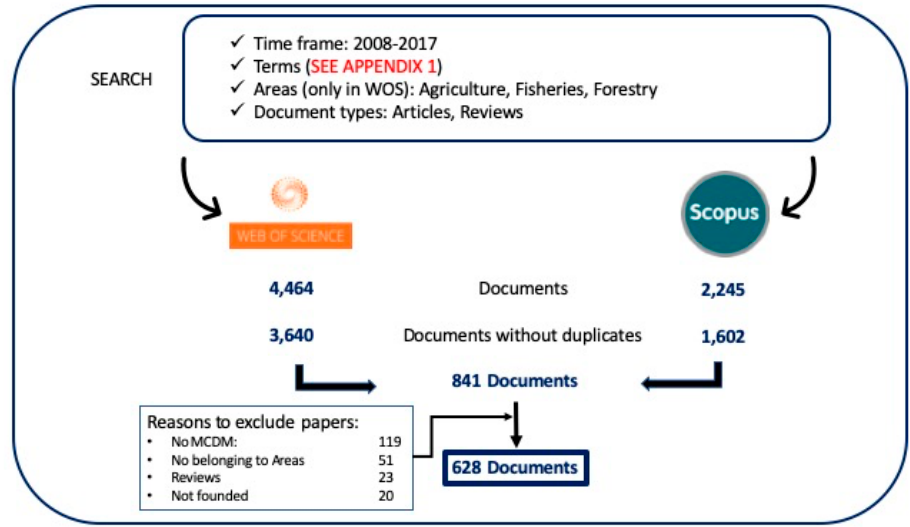
Figure 1. Diagram of search process.